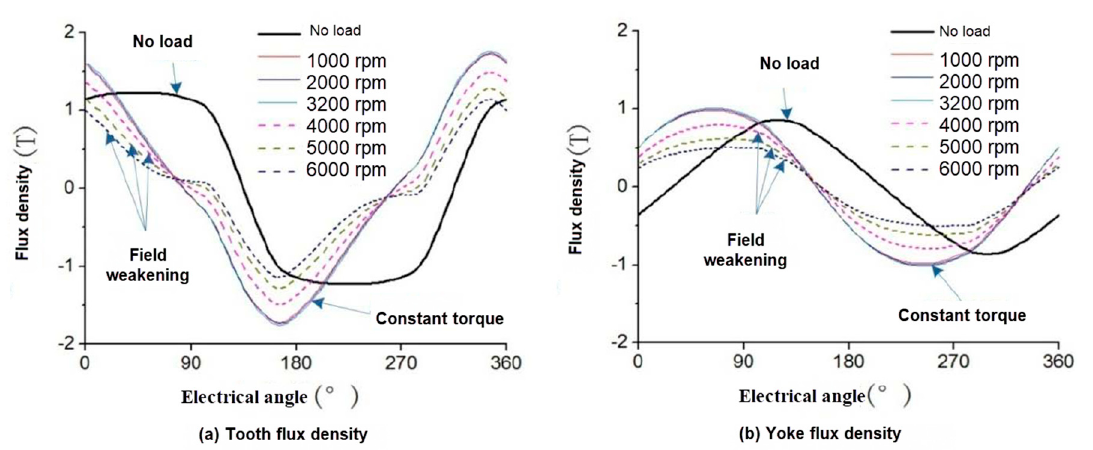
Figure 9. Changes in the radial flux density of the teeth and the tangential flux density of the yoke of the motor under different working conditions.